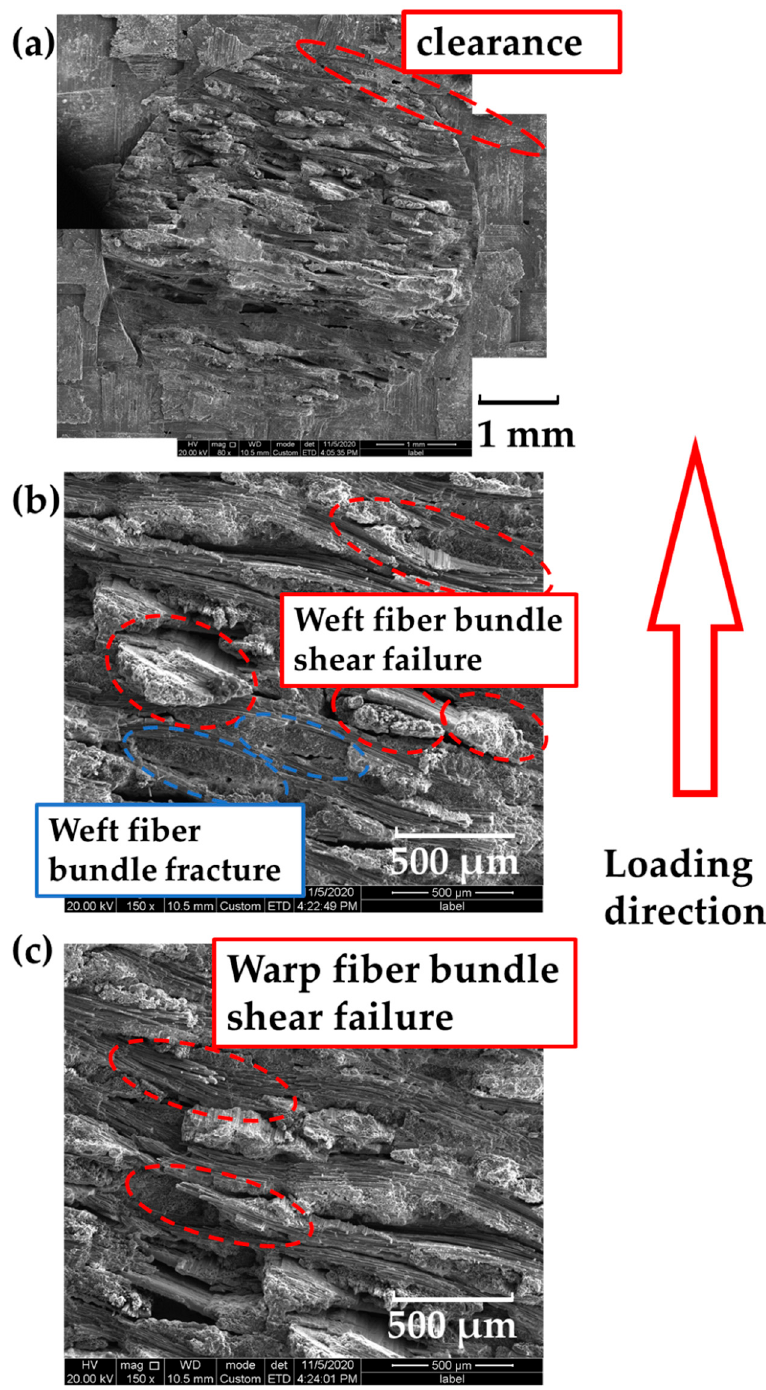
Figure 5. SEM photos of the z-pin on the fracture surface: ( a ) z-pin; ( b ) weft fibers; ( c ) warp fibers. From the SEM photograph of the fracture surface of the substrate plate, there was no complete secondary SiC deposition layer formed, but there existed several SiC deposition points distributed discretely, similar to the welding spots. The length of a single deposition point was close to half the wavelength of the woven structure. The width was relatively random, ranging from 1/4 fiber bundle width to nearly the entire fiber bundle width. Fiber fragments could be found on the SiC deposition spot, as shown in the marked area in Figure 6a. In contrast, outside the deposition areas, the fracture surface was relatively smooth with little fiber bundles, as shown in the marked area in Figure 6b. It means